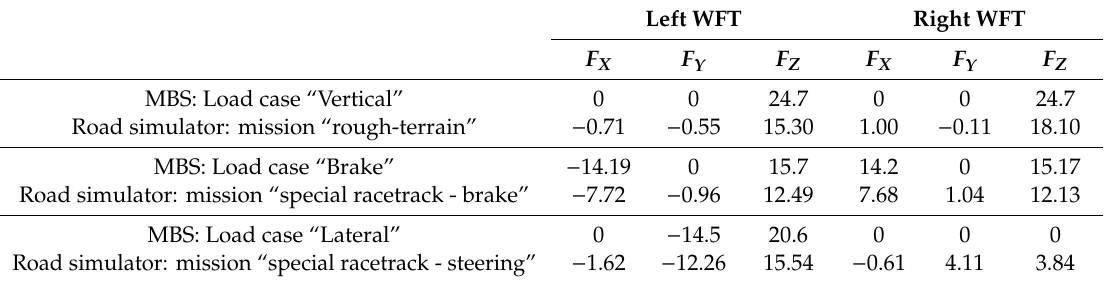
Table 4. Input for each load case applied in MSC / AdamsCar (Multibody Simulation MBS) and the related road simulator time histories.